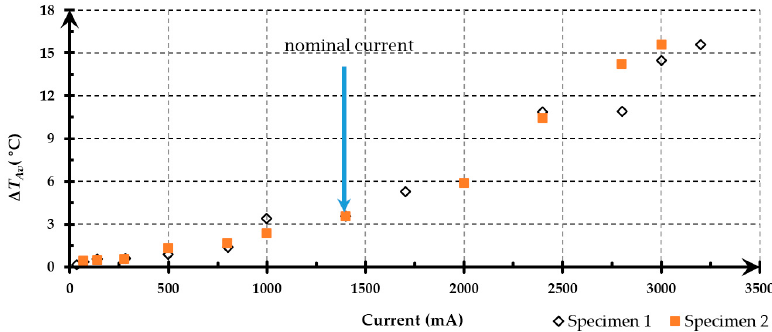
Figure 14. Average surface temperature increments ( Δ T Av ) of tested supercapacitors as a function of current.